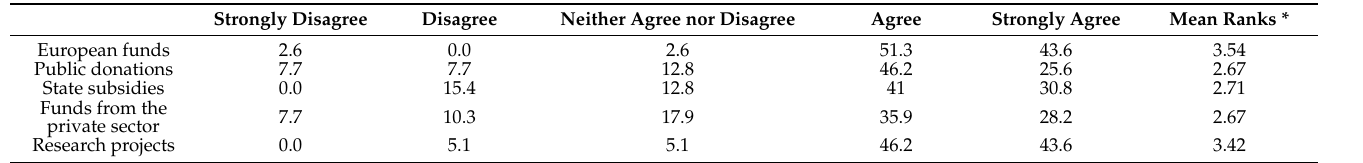
Table 12. Percentage units regarding the funding sources from which the Hub should be financed ( N = 39). Strongly Disagree Disagree Neither Agree nor Disagree Agree Strongly Agree